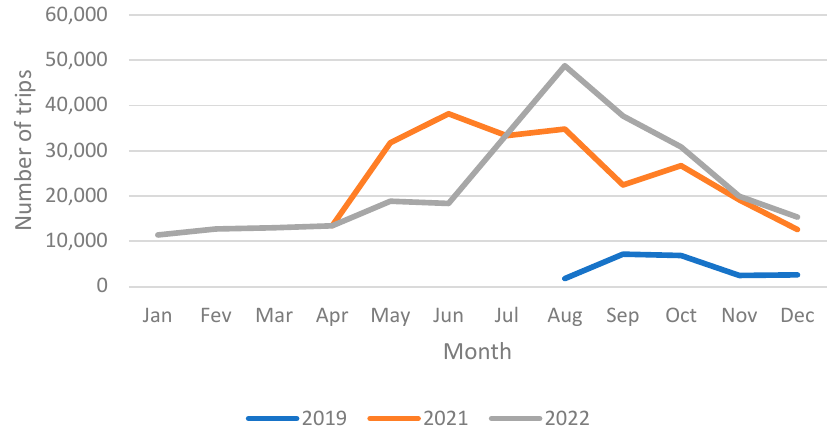
Figure 4. The number of trips by shared e-scooter usage in 2019, 2021, and 2022 in Braga.